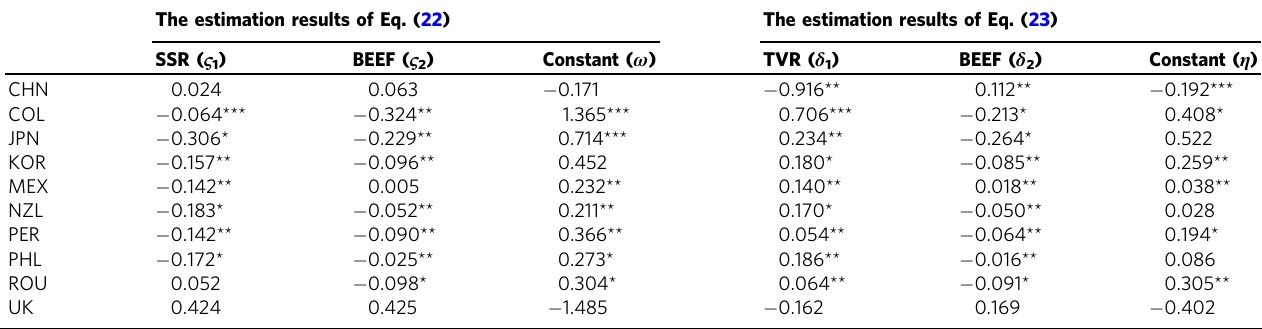
Table 12 The country-speci fi c results based on the random-coef fi cient regression model. The estimation results of Eq. (22) The estimation results of Eq.